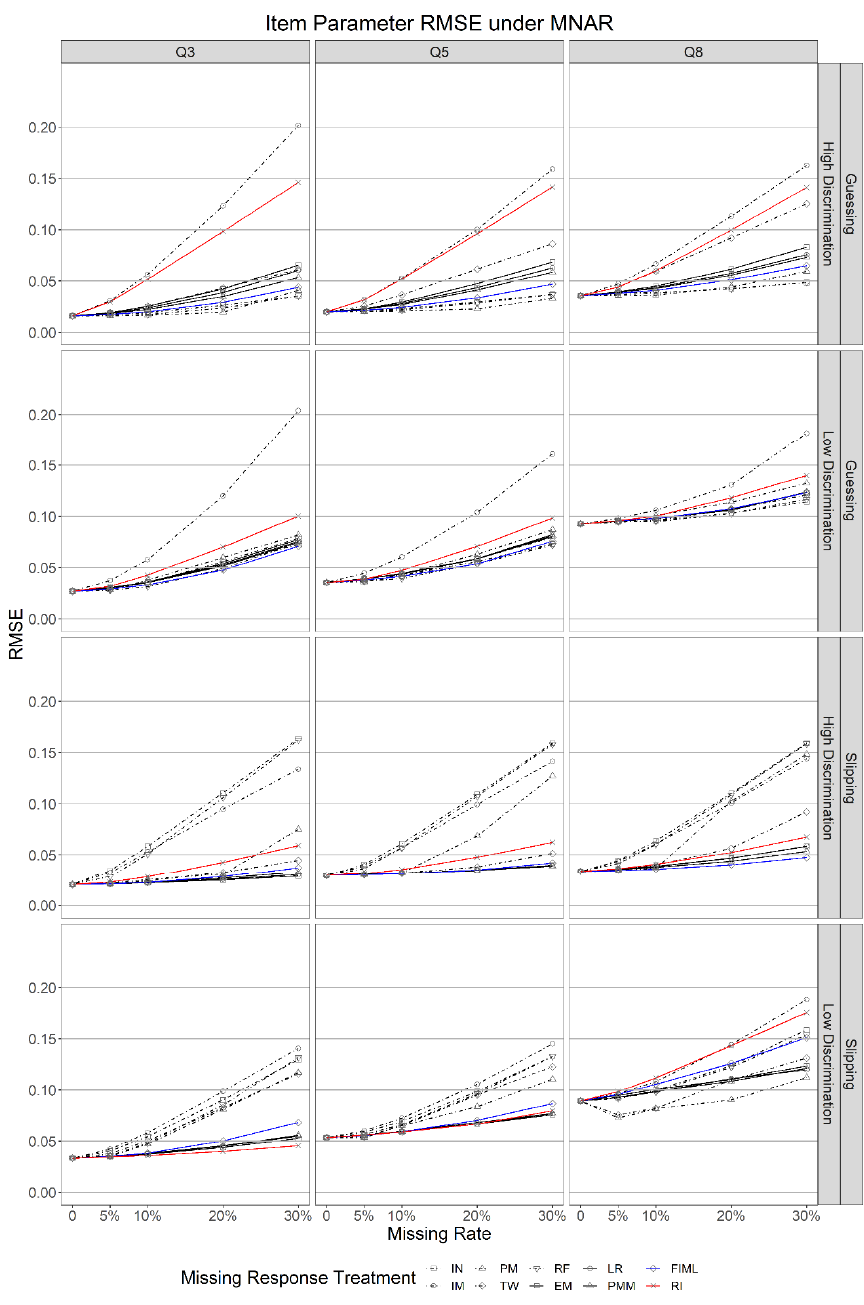
Figure 2. RMSE of item parameter estimations under the MNAR mechanism. Columns Q3, Q5, and Q8 present results for Q-matrices with three, five, and eight attributes, respectively, while rows refer to results across high and low discriminations for both guessing and slipping parameters.